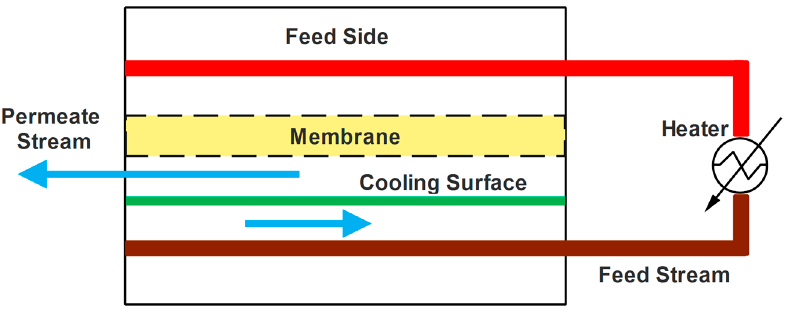
Figure 5. Schematic diagram of the multi ‐ effect membrane distillation (MEMD) [19] .